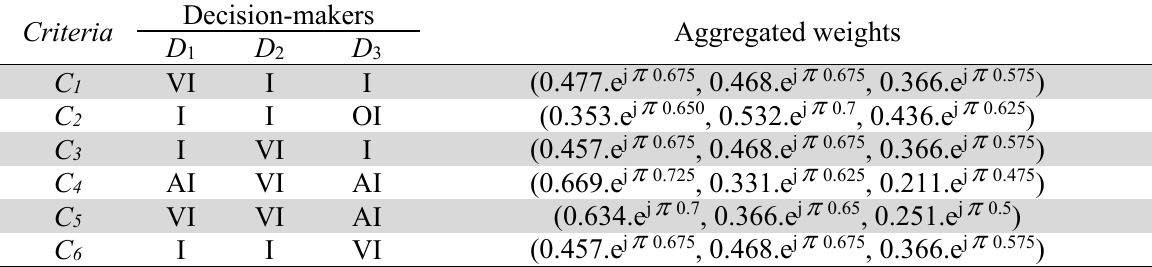
Table 2 The importance and aggregated weights of the criteria